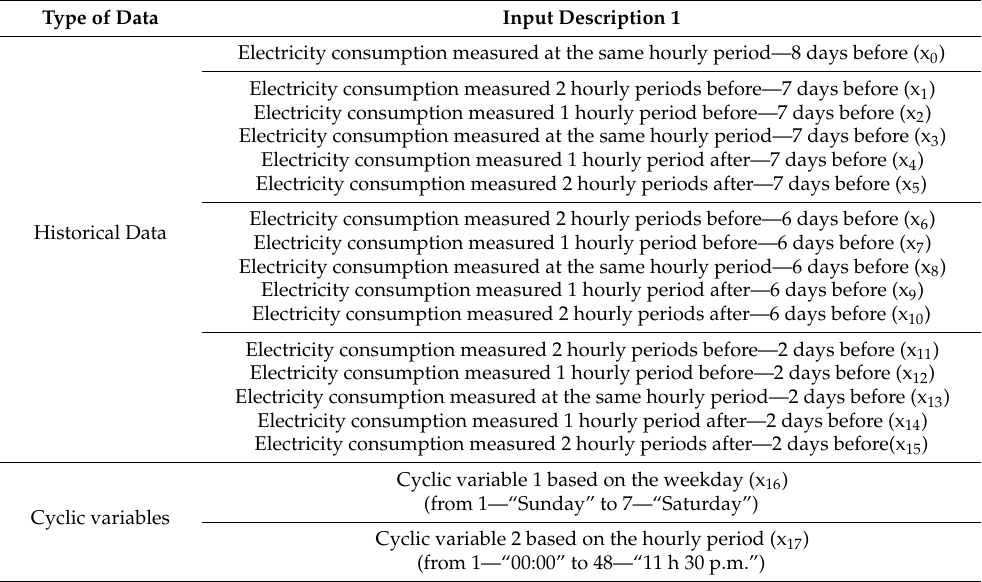
Table 2. Selected features to be integrated to characterize the